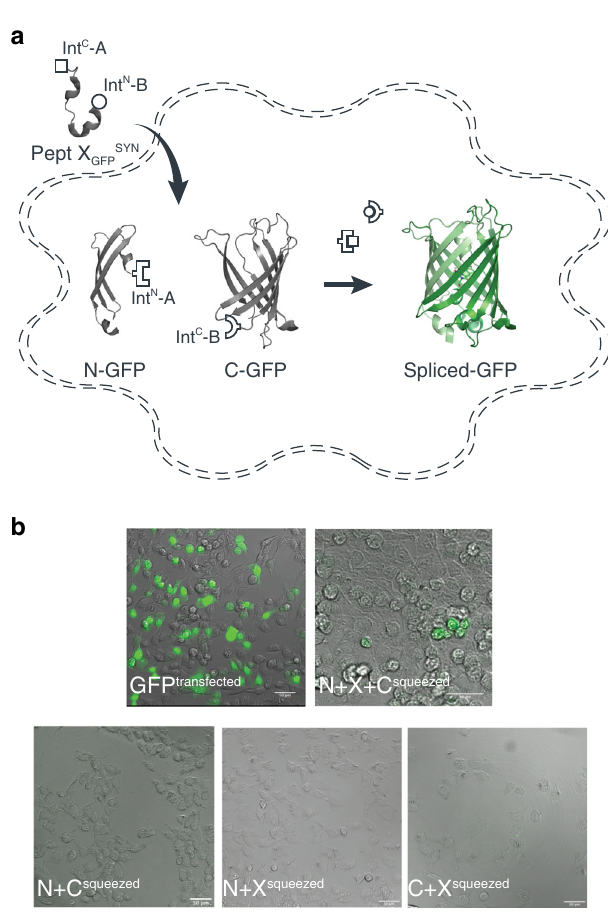
Fig. 5 Insertion of synthetic peptides into GFP. a Schematic of strategy applied to reconstitute GFP from recombinantly expressed N-/C-terminal fragments and a synthetic peptide X GFP SYN in HEK293 cells. b Overlay of bright- fi eld and fl uorescence images taken of HEK293 cells transfected with only WT GFP, or N and C fragments and squeezed in the presence or absence of peptide X GFP SYN . Scale bars: 50 µ